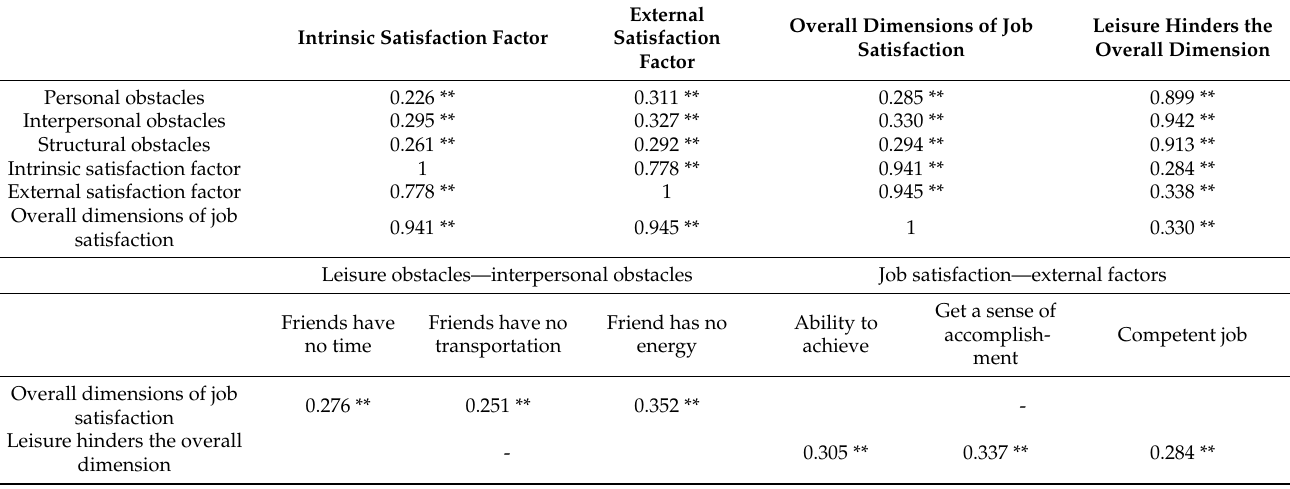
Table 8. Correlation analysis of leisure obstacles and job